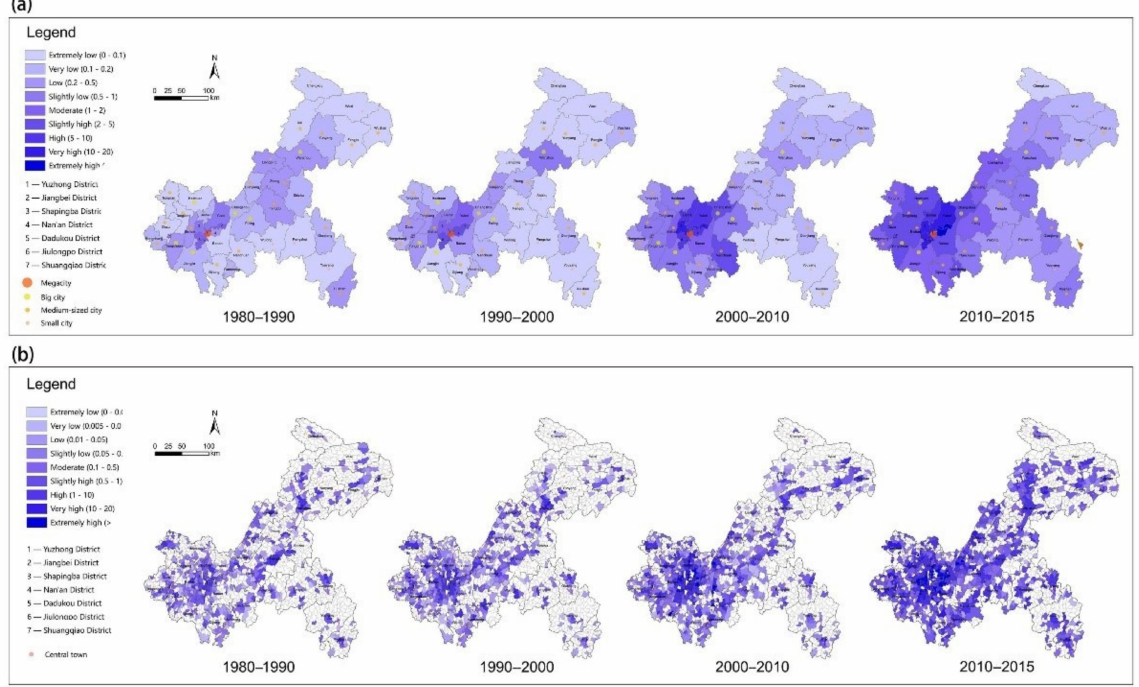
Figure 6. Spatiotemporal variation of ALCI at ( a ) the district/county level and ( b ) village level in Chongqing